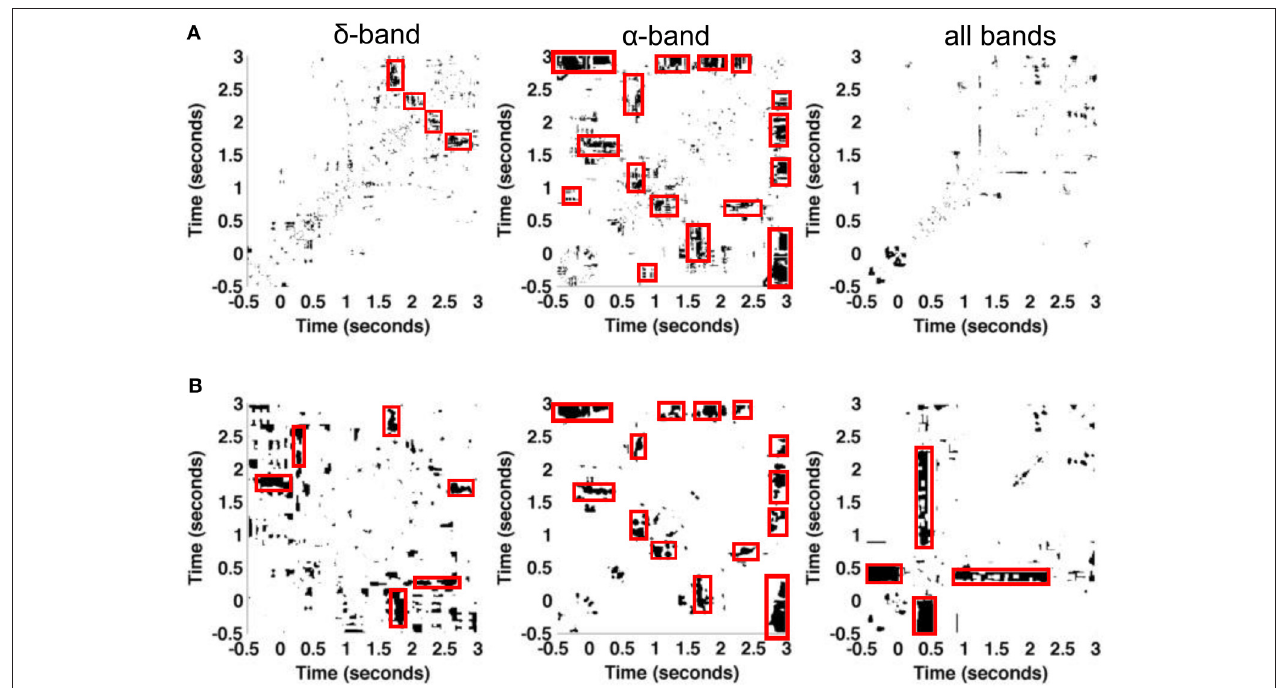
FIGURE 8 | Illustration of the influence of different visual pre-stimuli on resulting plots in experimental dataset. Statistically significant areas of recurrence plots are obtained by (A) pixel-wise chi-square tests and (B) t -test between trials with pre-stimulus black screen and those whose pre-stimulus is fox image . The data is taken from a single granular layer electrode in datasets session one and session two together. Both the pre-stimulus black screen and fox image have occurred three times among the 10 trials in each dataset. Significantly different values are coded as white pixels, statistically similar values are coded as black